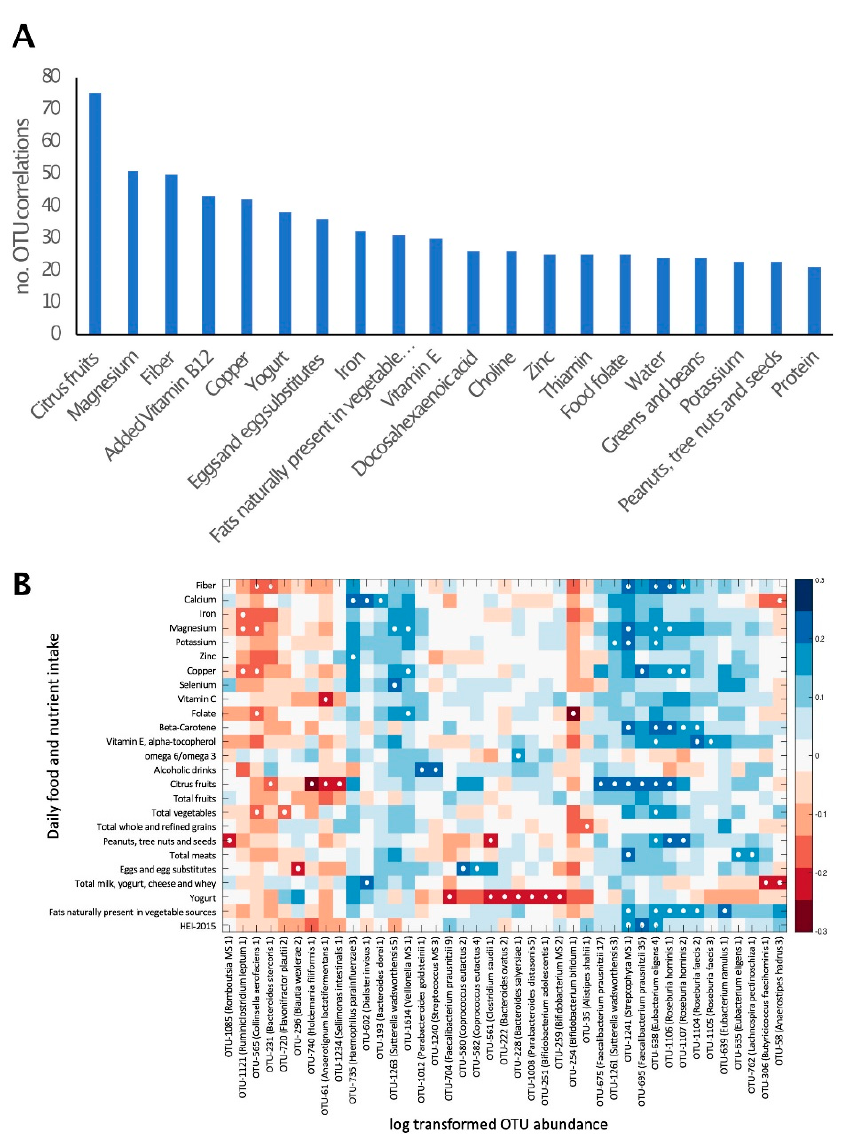
Figure 2. Daily nutrient and food group intake is correlated with gut microbiome composition. ( A ). The number of bacterial taxa showing significant ( p < 0.01) correlation with the intake of selected nutrients and food groups. Twenty dietary factors showing correlations to the highest number of bacterial taxa are presented. ( B ). Heat map of a univariate Kendall correlation matrix of selected taxa abundance (log2; x -axis) vs. daily food and nutrient intake ( y -axis). Heatmap is sorted based on a hierarchical clustering of OTUs. Blue shades indicate positive correlations while red shades indicate negative correlations ( − 0.3 < tau < 0.3). Statistically significant correlations are marked with a white circle. Food intake units are provided in Table 3. HEI 2015–Healthy Eating Index